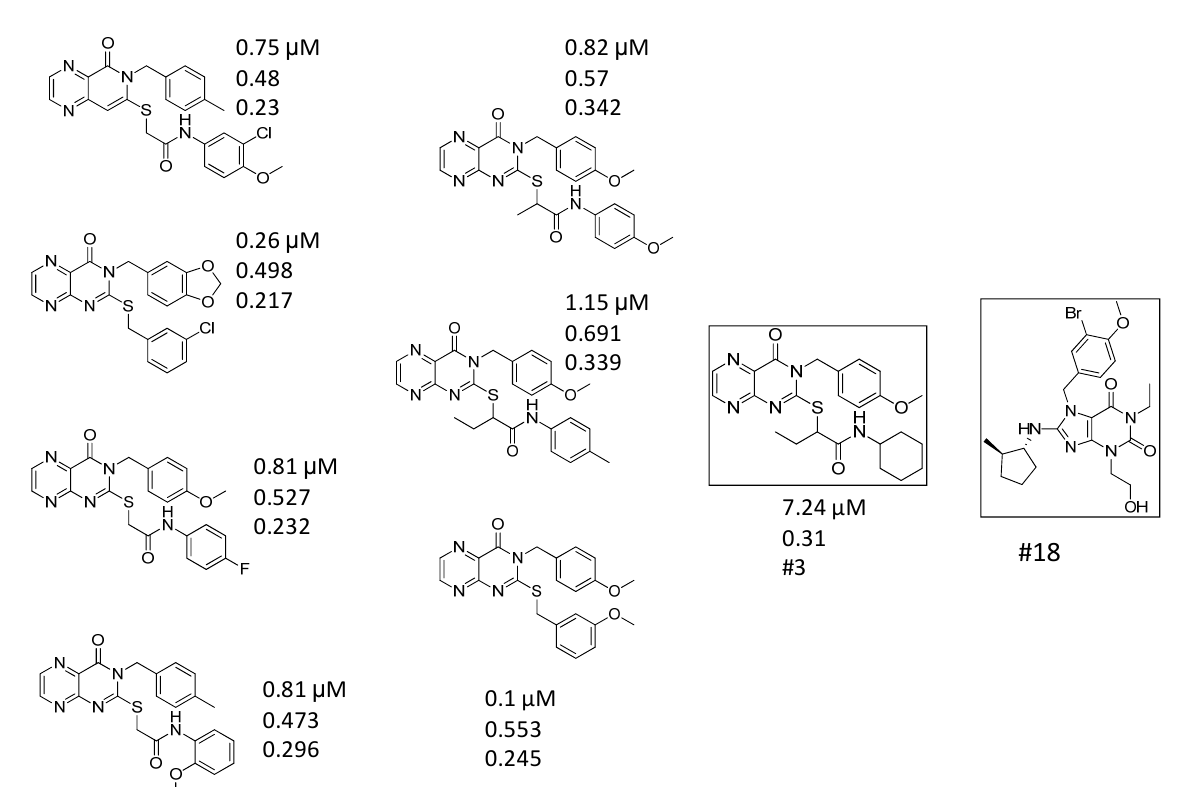
Figure 4. Hits derived from #18 seed with the T3D similarities to the first round hit and seed (reference compound)—Series